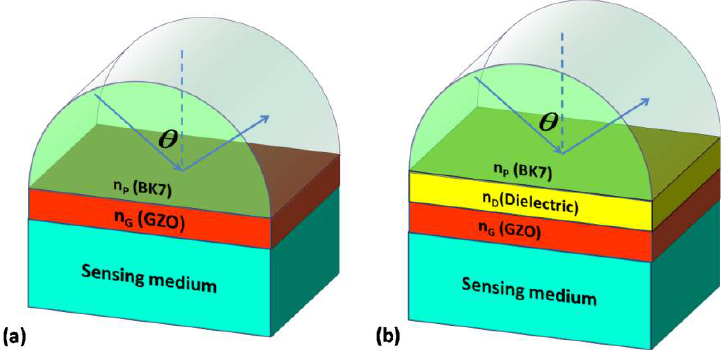
Figure 1. ( a ) Schematic diagram of a surface plasmon resonance (SPR) sensor based on Ga-doped zinc oxide (GZO); and ( b ) schematic diagram of a long-range surface plasmon resonance(LRSPR) sensor based on GZO.